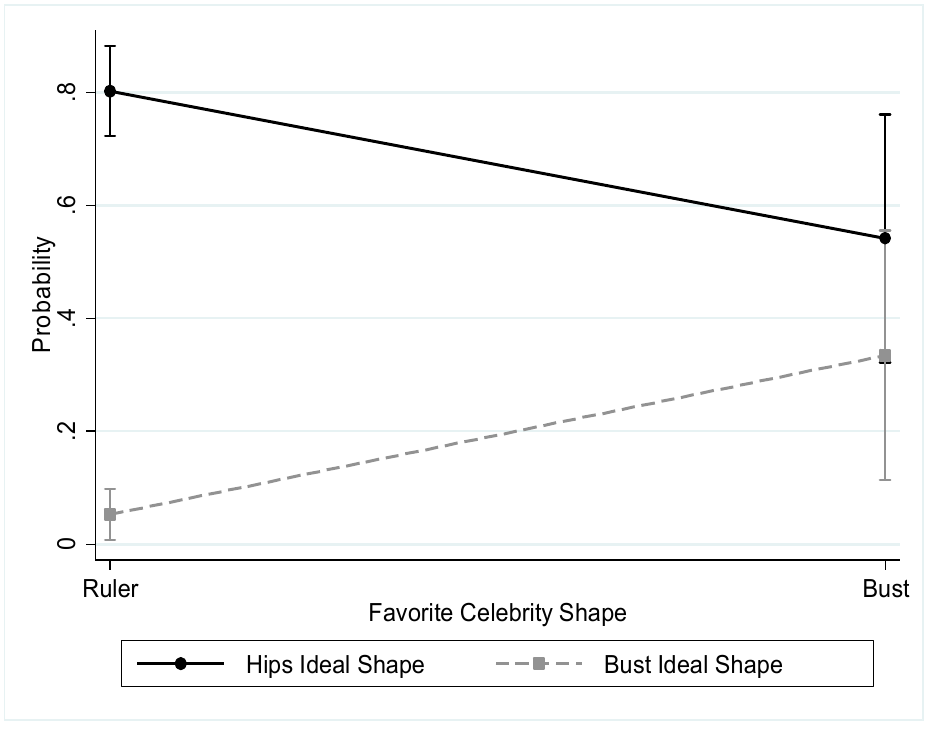
Figure 4. Predictive Margins for Thin models Treatment and Favorite Celebrity Body Shape (Bust versus Ruler).